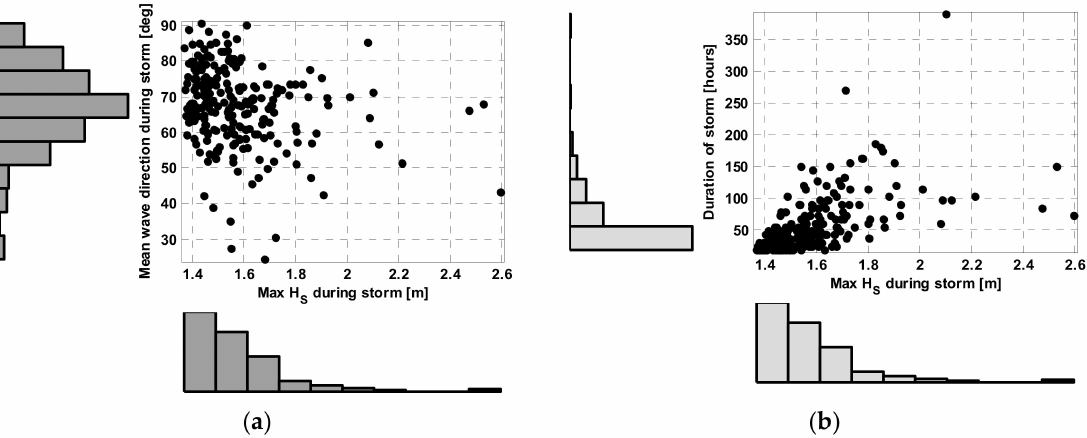
Figure 10. Dependency between maximum significant wave height and average wave direction—( a panel),